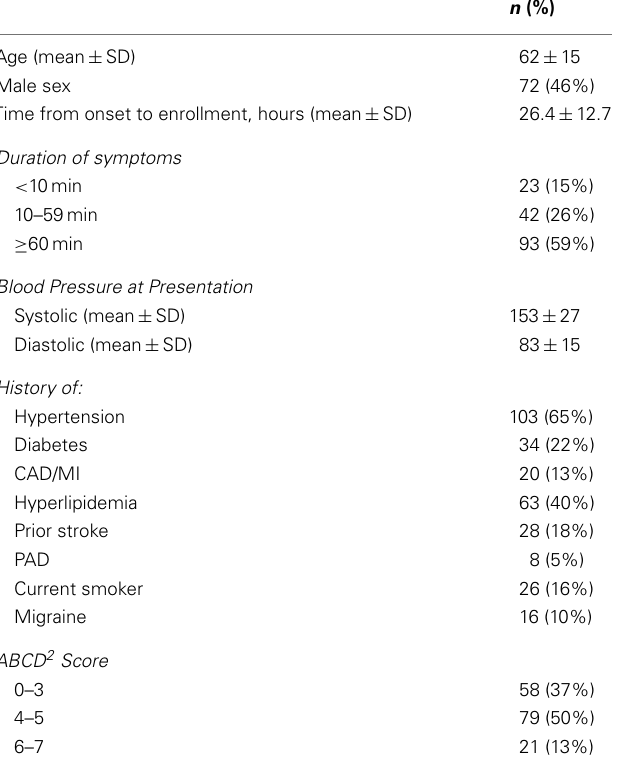
Table 1 | Baseline characteristics.